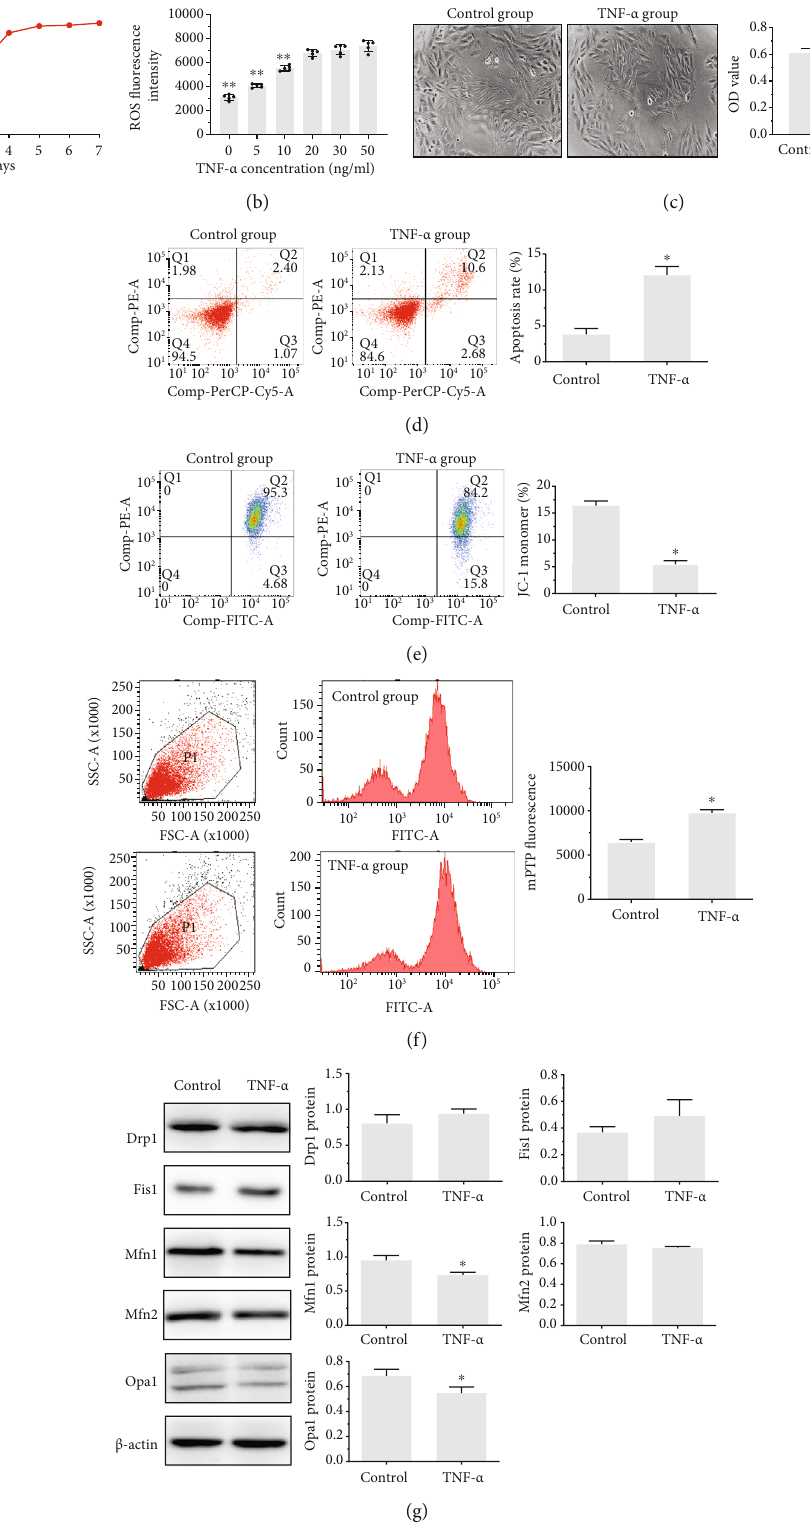
Figure 9: Impacts of TNF- α exposure on mitochondrial function of H9C2 cell lines. Evaluation of cell variability by cell growth curve (a). Screening of the optimal TNF- α -disposed concentration by ROS fl uorescence intensity detections (b). Detections of cell proliferation by CCK-8 assay (c). Measurements of apoptosis rate, MMP, and mPTP by fl ow cytometry (d – f). Results of mitochondrial dynamics-related proteins between control and experimental groups by western blot (g). ∗ P < 0 : 05 vs. control group. ROS: reactive oxygen; MMP: mitochondrial membrane potential; mPTP: mitochondrial permeability transition